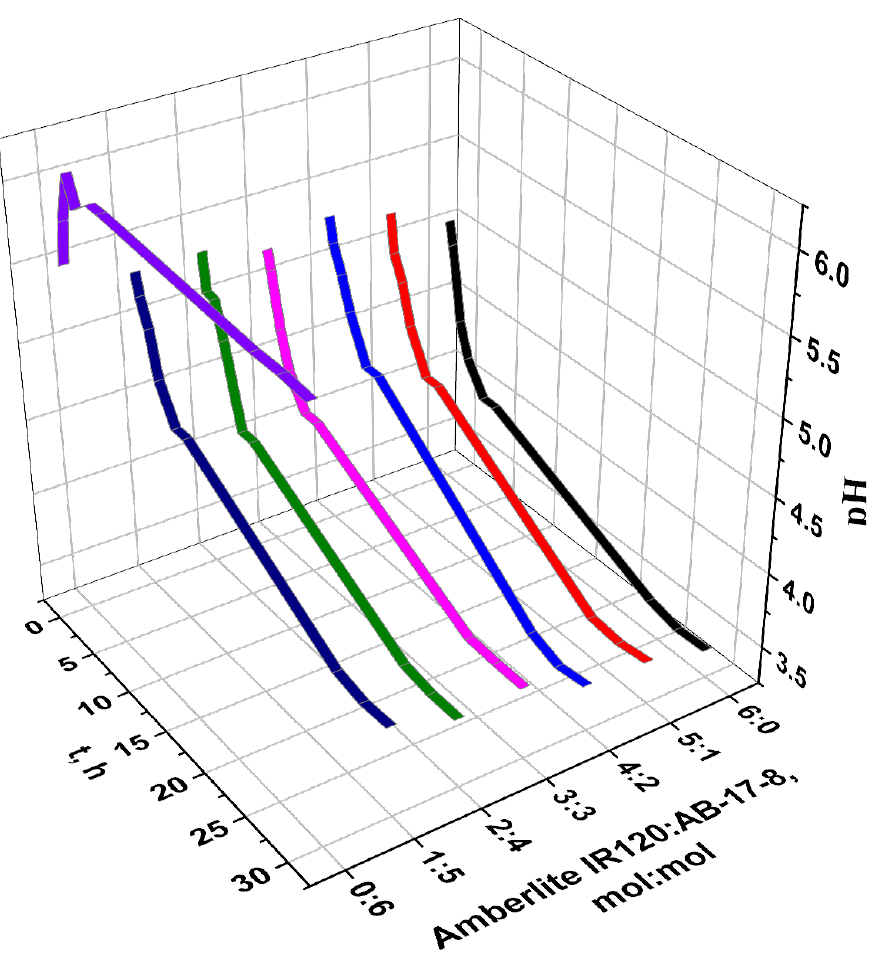
Figure 3. The pH of europium nitrate in dependence from molar ratios of ion exchangers and time.